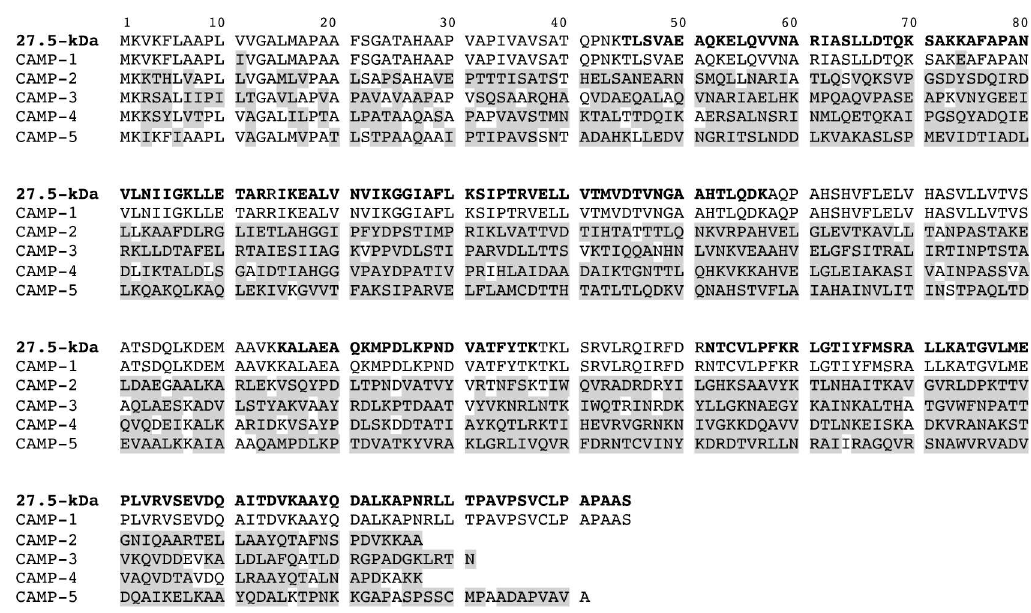
Fig 5. Comparison of the sequences of the 27.5 kDa P . acnes surfaceprotein and P . acnes CAMP factors. The peptidesequenceof the 27.5 kDa protein was obtainedafter LC-MS/MS analysiscorresponding to 66% coverage(in bold), as describedin the Materials and Methods. It was comparedwith the sequencesof P . acnes CAMP factors 1 to 5 (Reference strain NCTC 737, GenBank accession number AY527218.1). Differences betweensequencesare highlighted in gray.